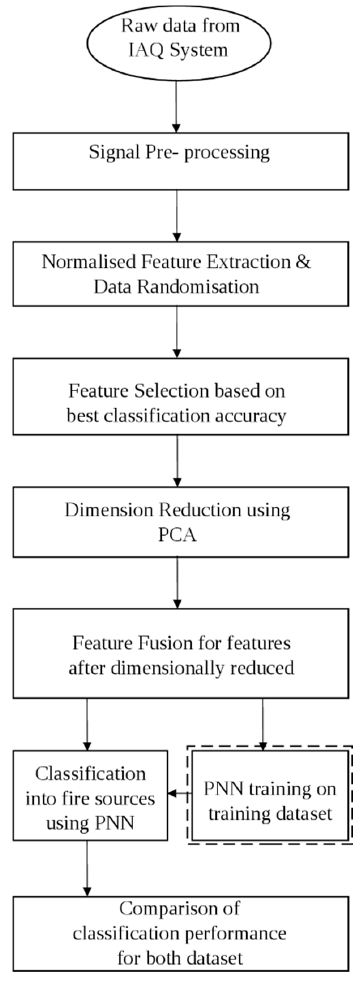
Figure 1. A flowchart of the proposed multi- stage feature selection approach using PCA and PNN.